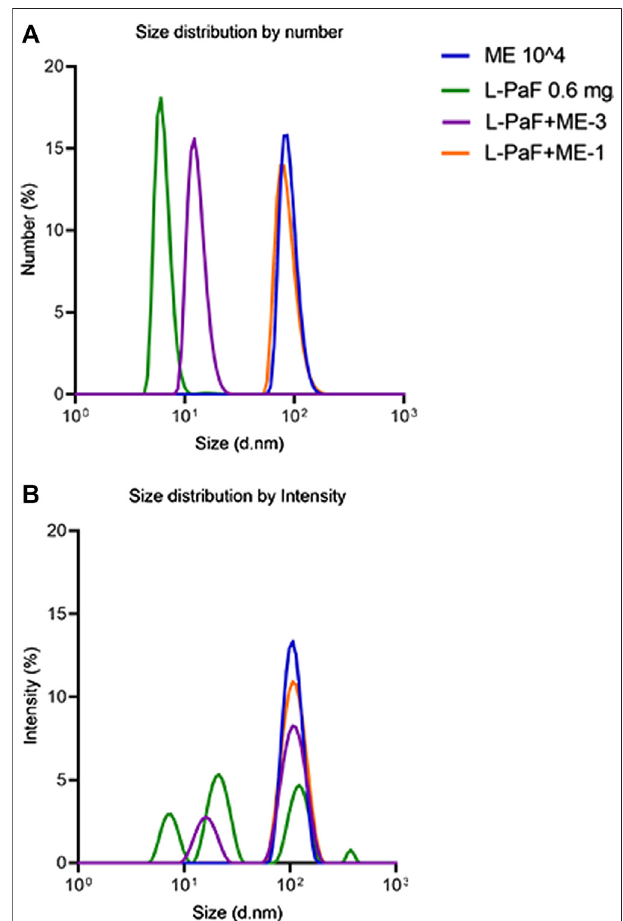
FIGURE 1 | Particle size determined by multi-angle dynamic light scattering (MADLS). (A) Number weighted size distribution of 0.6 mg/mL L-PaF alone (green), 10,000-fold diluted ME emulsion alone (ME, blue plot), L-PaF + 10,000X diluted ME (ME-3) and L-PaF + 1,000X diluted ME (ME-1, orange). (B) Intensity weighted size distribution of 0.6 mg/mL L-PaF alone (green), 10,000X diluted ME emulsion (blue), L-PaF + 10,000X diluted ME (purple) and L-PaF + 1,000X diluted ME